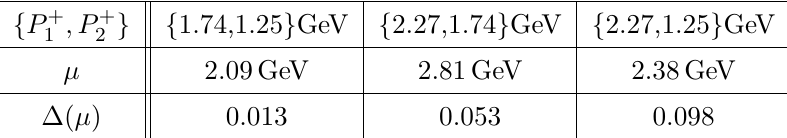
Table 2 . Shifts ∆( µ ) for the CS kernel K ( b, µ ) , as used in this work, to evolve the CS kernel from q 2 P + to µ = 2 GeV µ = P + 1 2